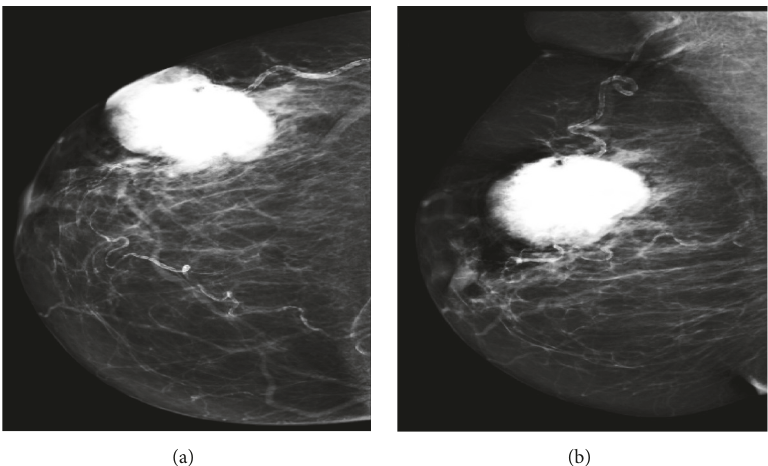
Figure 3: MLO (a) and CC (b) mammogram views of the right breast revealed a heavily calcified lobulated mass in the outer mid breast measuring 4.8 × 3.9 cm adjacent to a blood vessel with minimal perilesional edema.